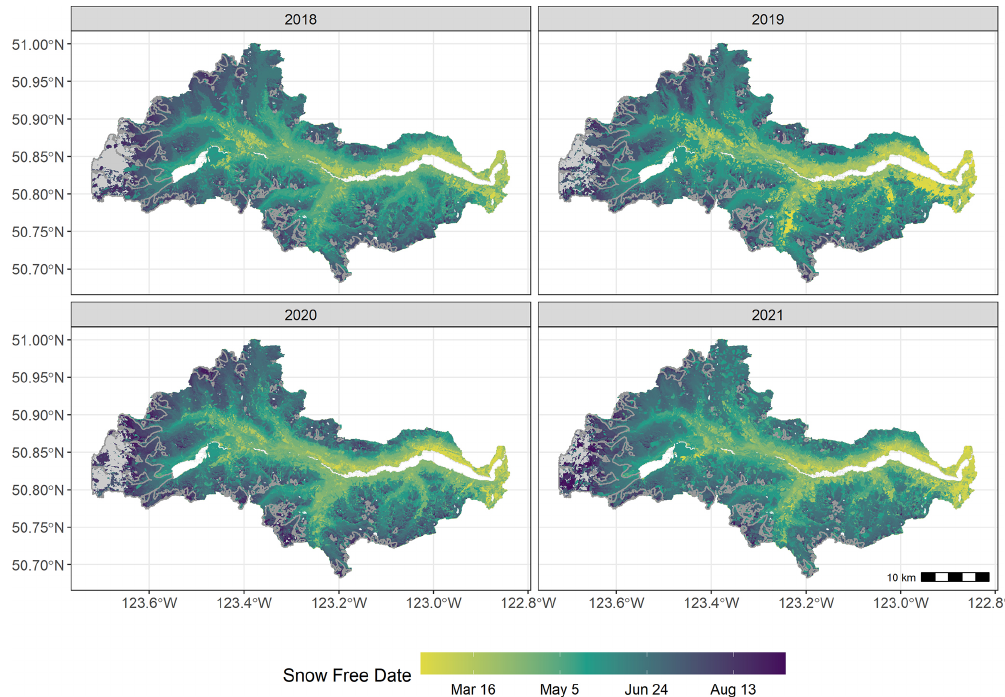
Figure 8. Estimates of snow-free dates in the La Joie Basin from Landsat-8 and Sentinel-2. Grey shading represents perennial snow, and the grey outlines delineate glaciers.